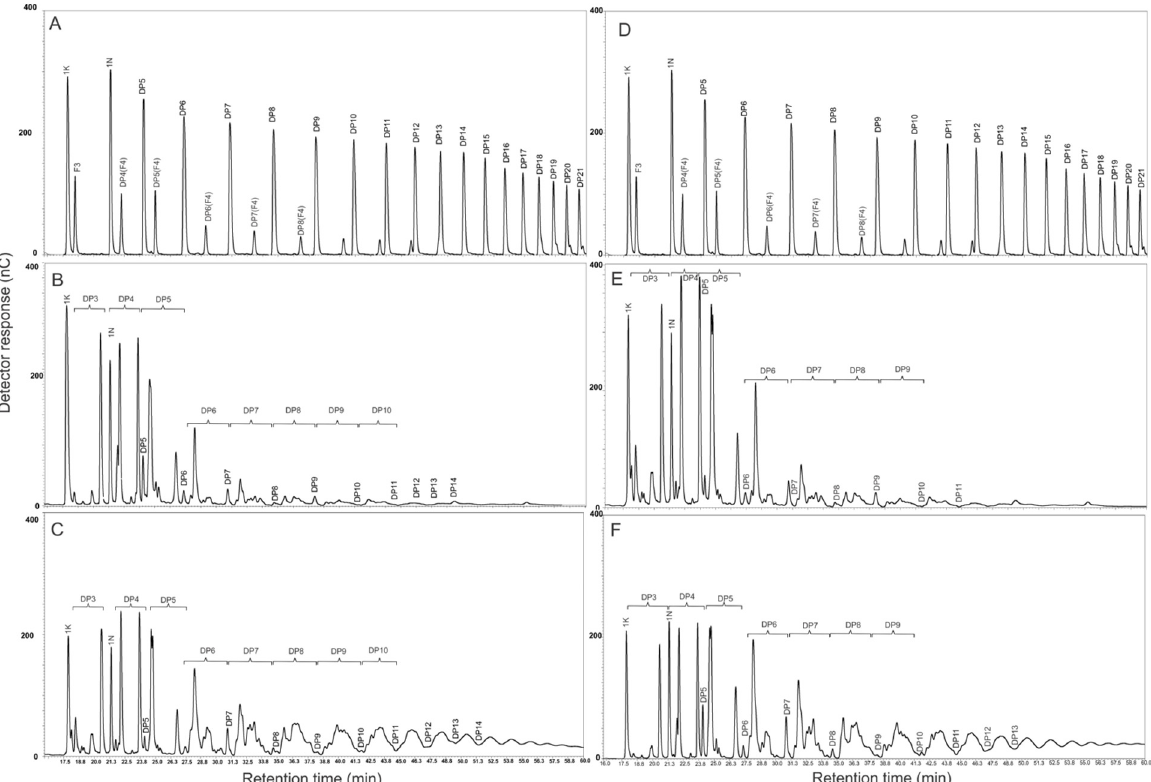
Figure 6. HPAEC-PAD profiles of fructans from ( A , D ) raftiline (RNE), ( B ) 1-year-old A. angustifolia plants, ( C ) 6-year-old A. angustifolia plants, ( E ) 1-year-old A. potatorum plants, and ( F ) 6-year-old A. potatorum plants. Table 2. Carbohydrate and fructooligosaccharide content of A. angustifolia Haw. plants at different ages.